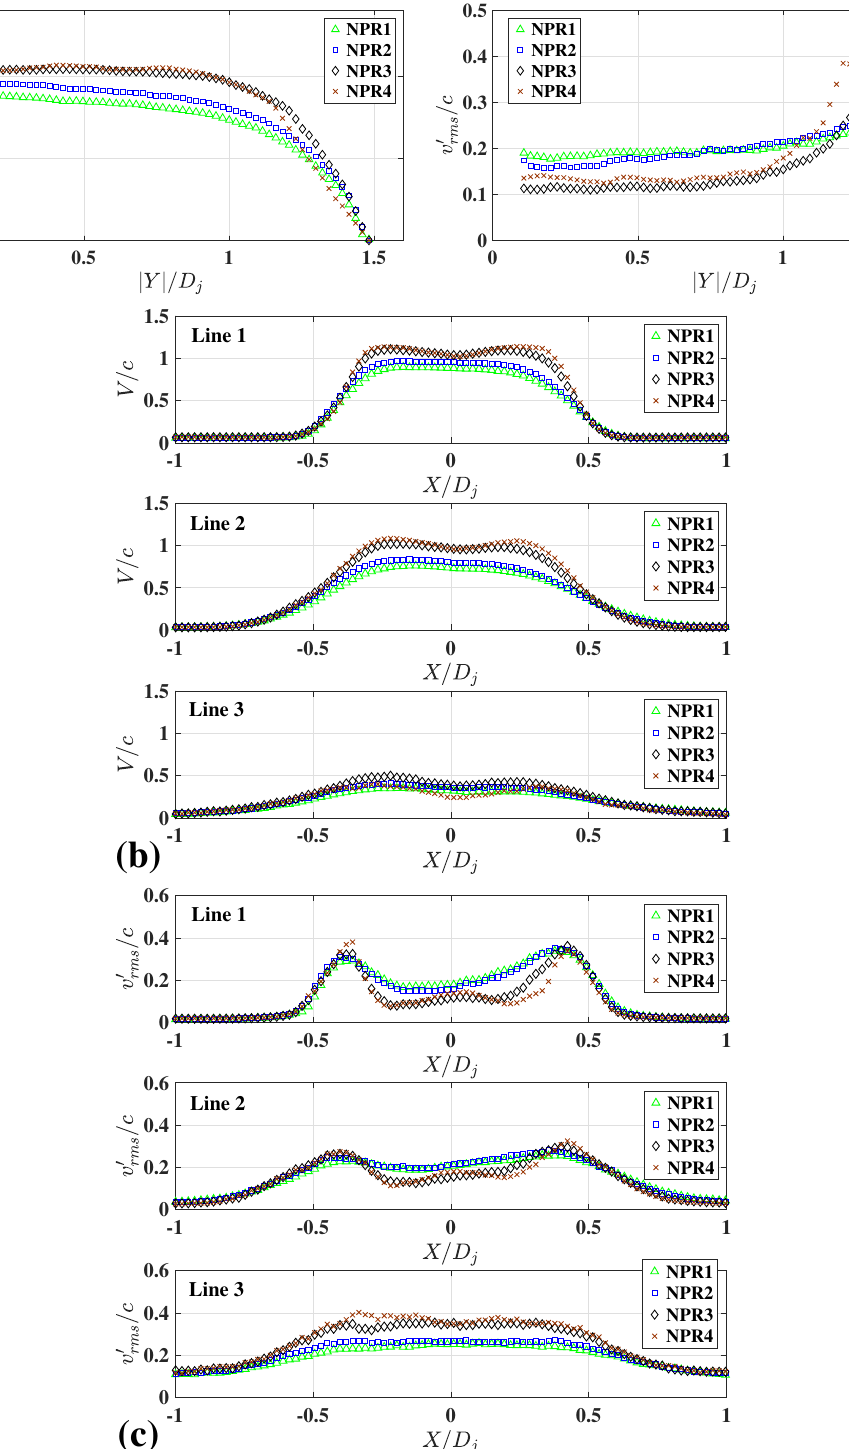
Figure 8. Comparisons of statistical results obtained from PIV measurements of under-expanded impinging jets with e = 20 mm ( e / D j = 1.64) for various values of NPRs, i.e., NPR 1 = 2, NPR 2 = 2.2, NPR 3 = 2.5, and NPR 4 = 2.77. ( a ) Normalized mean axial velocity, V / c and normalized RMS fluctuating axial velocity v (cid:48) rms / c along the jet centerline ( x = 0); ( b , c ) showed normalized statistical profiles of V / c and v (cid:48) rms / c , respectively, obtained along Line 1 ( y = − 2.54) mm, Line 2 ( y = − 12.7) mm, and Line 3 ( y = − 17.46)